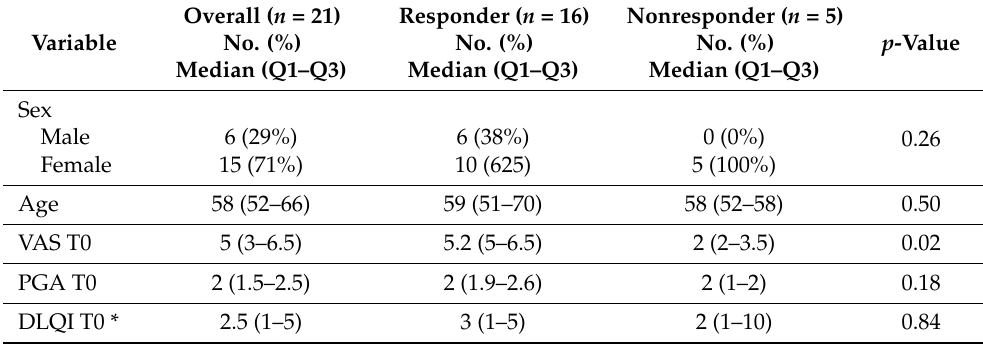
Table 3. Wilcoxon rank-sum test comparing patients who initially responded to topical CSA treatment (responders; n = 16) with those who did not respond (nonresponders; n = 5). Responders had significantly higher baseline VAS scores than nonresponders (bold number), but groups did not differ significantly regarding other characteristics. * Evaluation of baseline DLQI scores was based on 17